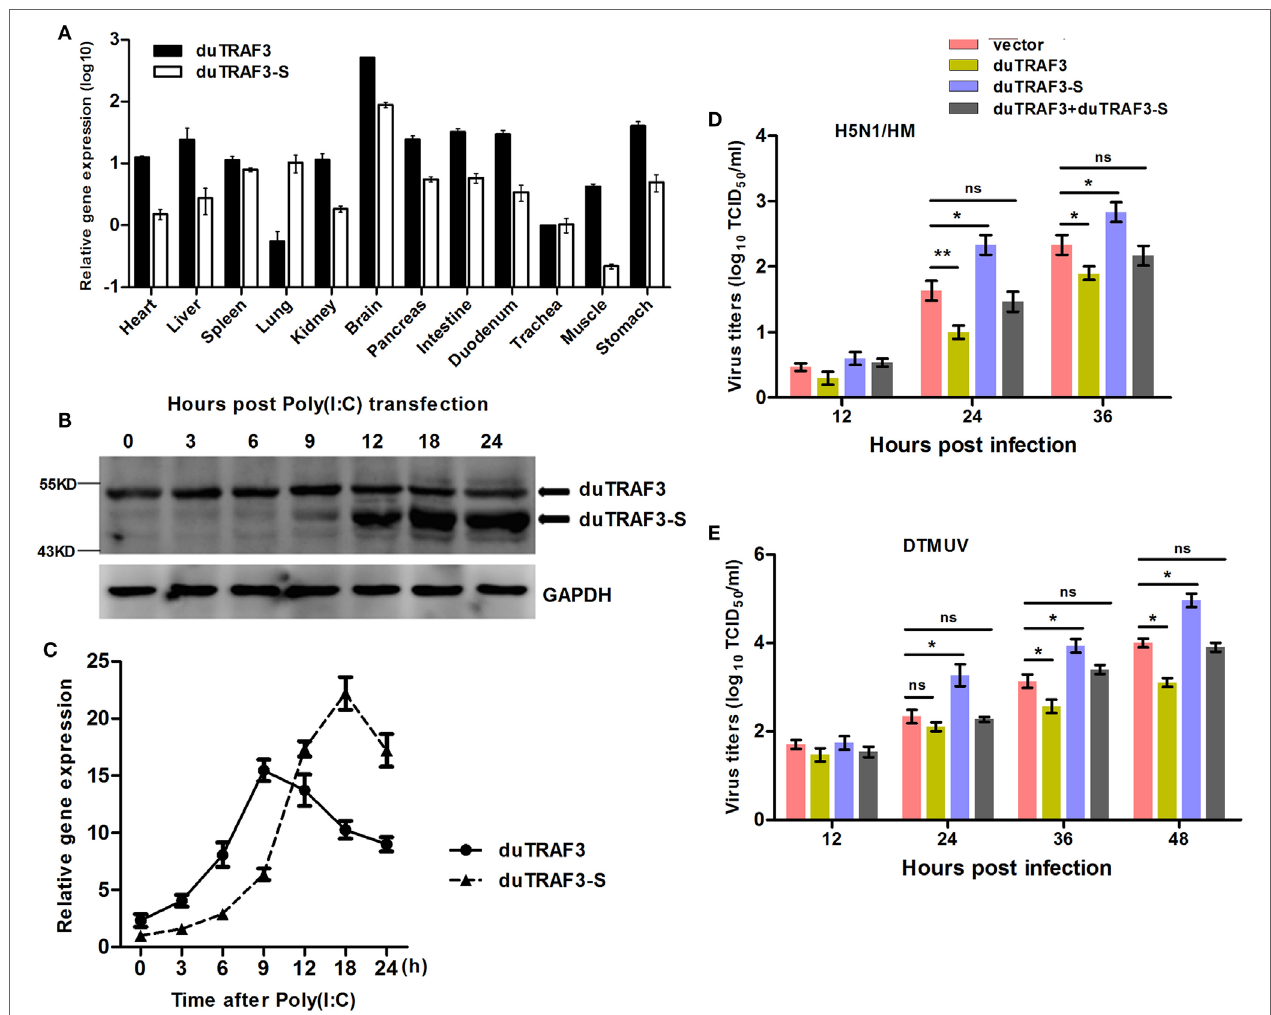
FigUre 2 | Analysis of expression patterns of duck TRAF3s (duTRAF3s) and the effects on viral replication. (a) Constitutive expression of duTRAF3 and spliced isoform of duTRAF3 (duTRAF3-S) transcripts in healthy duck tissues were performed by quantitative real-time PCR (qRT-PCR). The mRNA expression levels were expressed as relative mRNA indexes, calculated as index (duTRAF3 mRNA or duTRAF3-S mRNA copy number/GAPDH mRNA copy number) of test tissue divided by index of trachea. (B,c) Duck embryo fibroblasts (DEFs) were treated with poly(I:C) (2 µg/ml) for the indicated time points. The mRNA and protein levels of duTRAF3 were detected. (D,e) DEFs were transfected with duTRAF3, duTRAF3-S, duTRAF3, and duTRAF3-S, or an empty vector for 24 h and then infected with H5N1/HM virus at multiplicity of infection (MOI) of 0.001 or duck Tembusu virus (DTMUV) at MOI of 1. Culture supernatants were collected for detecting the viral titers, which was measured by TCID 50 assay. All data were presented as the means ± SD derived from three repeat experiments. * P < 0.05 or ** P < 0.01 (Student’s t